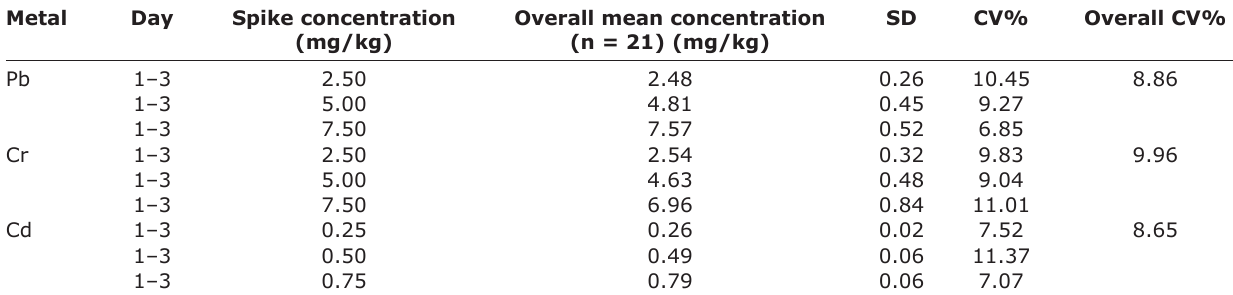
Table-6: The reproducibility data of heavy metals in poultry feed. Metal